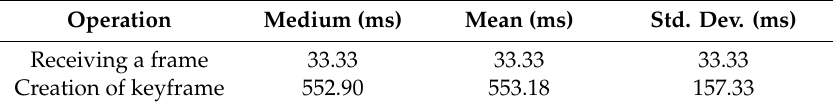
Table 9. Computation time for creating one keyframe in visual tracking